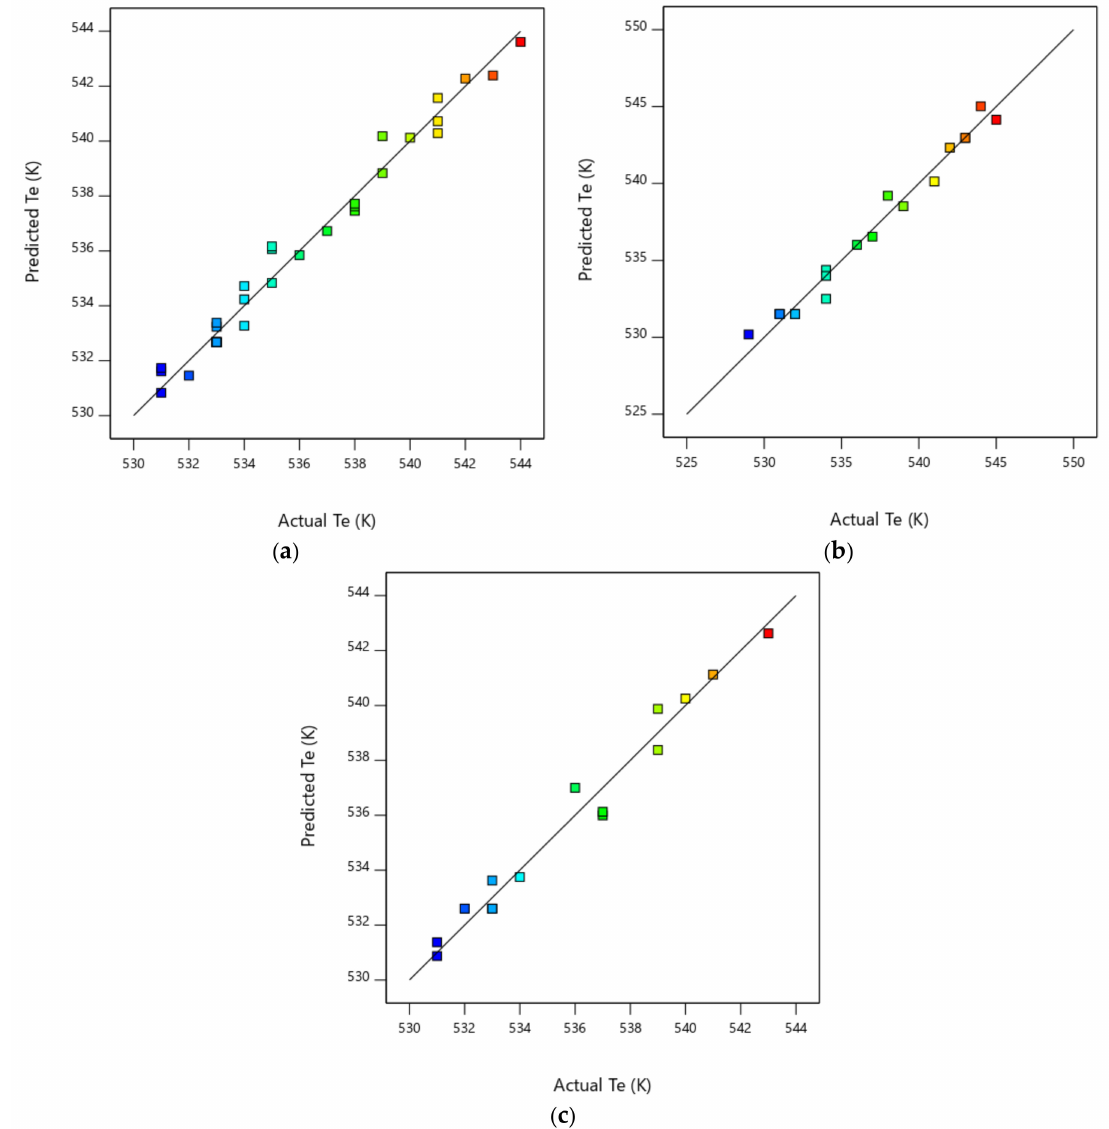
Figure 10. T e predicted vs. T e actual: ( a ) Complete design; ( b ) Central composite design; and ( c ) Box–Behnken